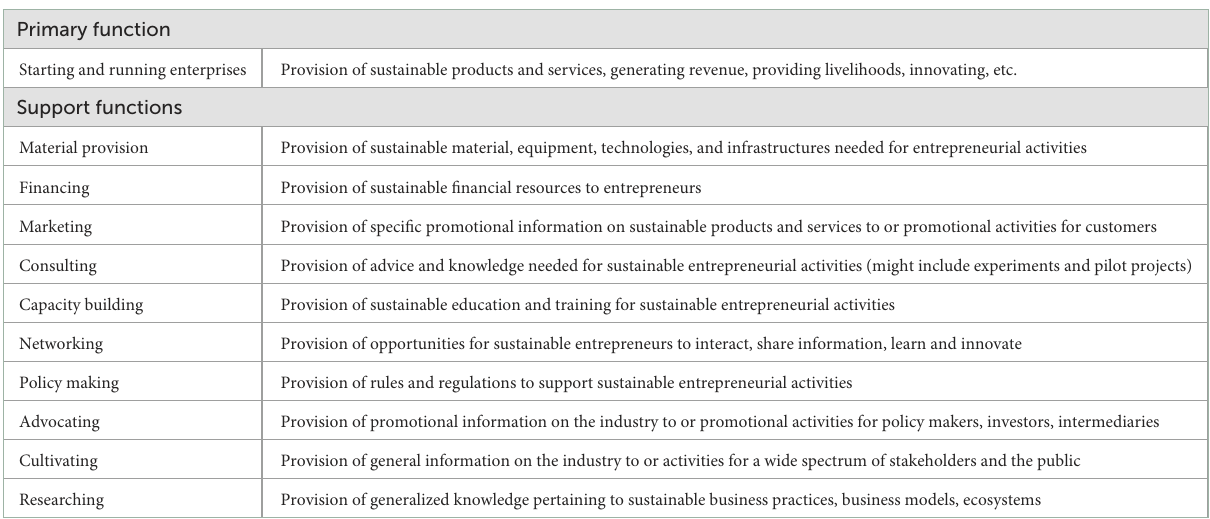
TABLE 2 Functions of SEEs (Forrest et al.,